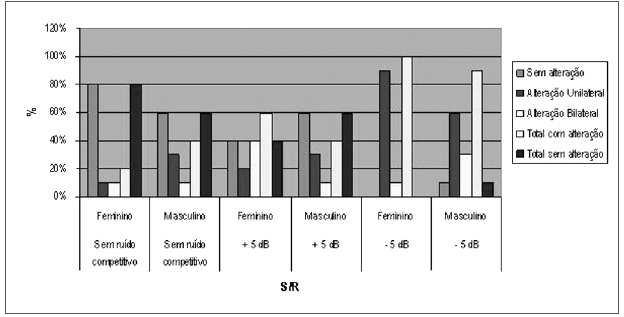
Figura 4. Porcentagem de alterações no IPRF, ocorridas após a ex- posição à música na relação, por sexo, nas diferentes relações S/R